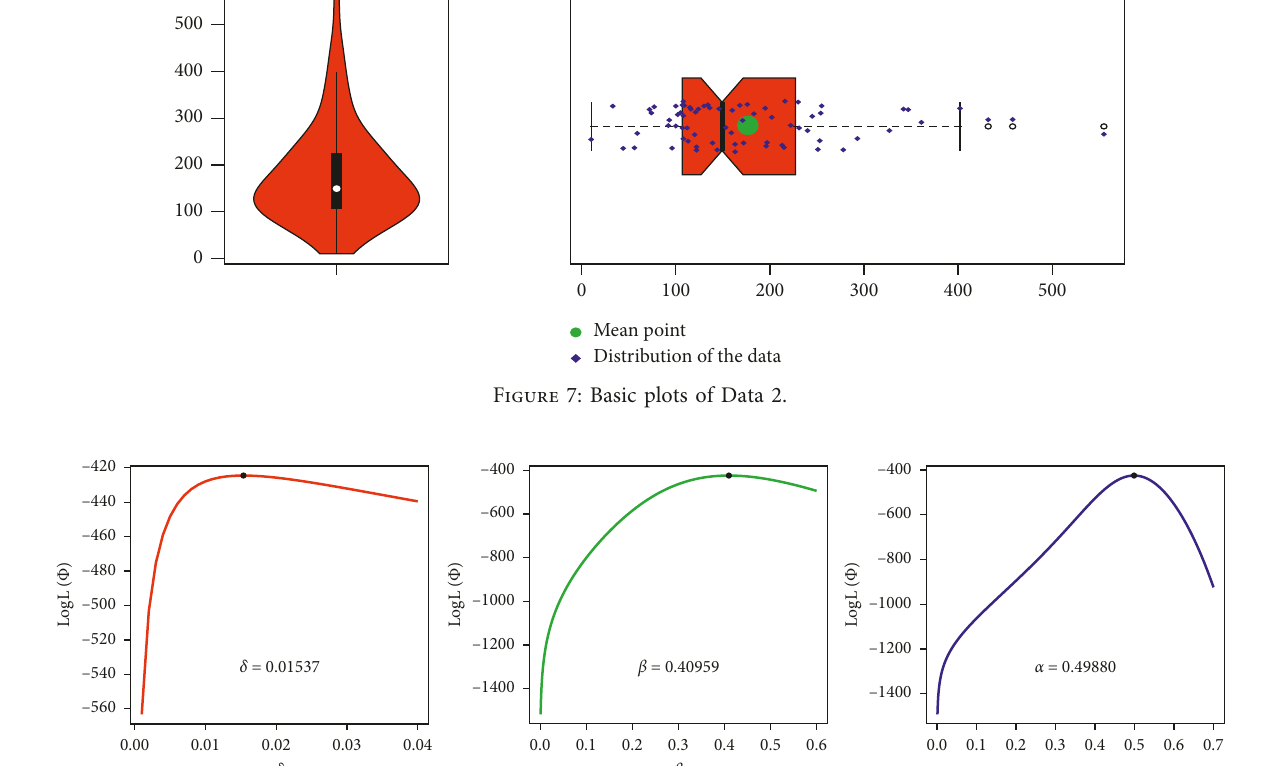
Table 7: The values of 􏽢 α